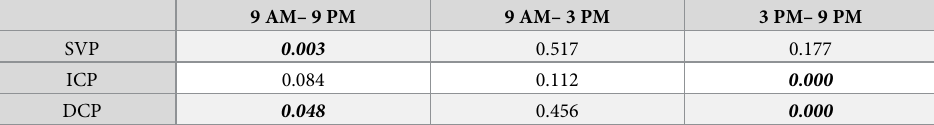
Table 2. P-values generated from pairwise comparisons of mixed model analysis showing significant changes of mean sectorial VD in all 12 sectors between the measurement times for each retinal sublayer.